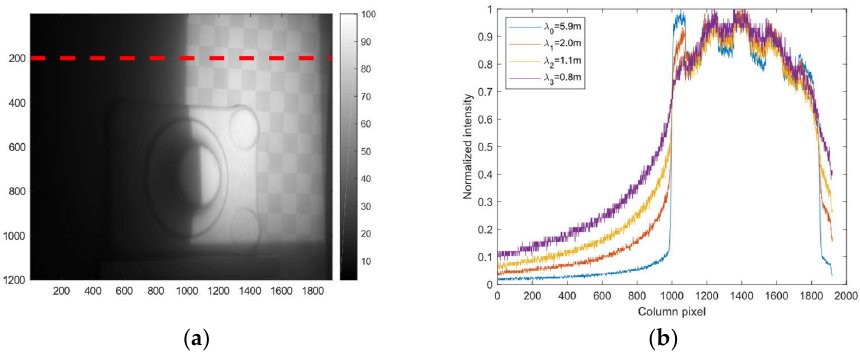
Figure 4. Point spread function of forward scatter. ( a ) Shows a projected Gray code. ( b ) Shows the normalized intensity profile along the red stapled line across turbidities. Notice the increase in width of the PSF with increasing turbidity. In the absence of forward scatter, the intensity left of pixel 1000 should have been zero.